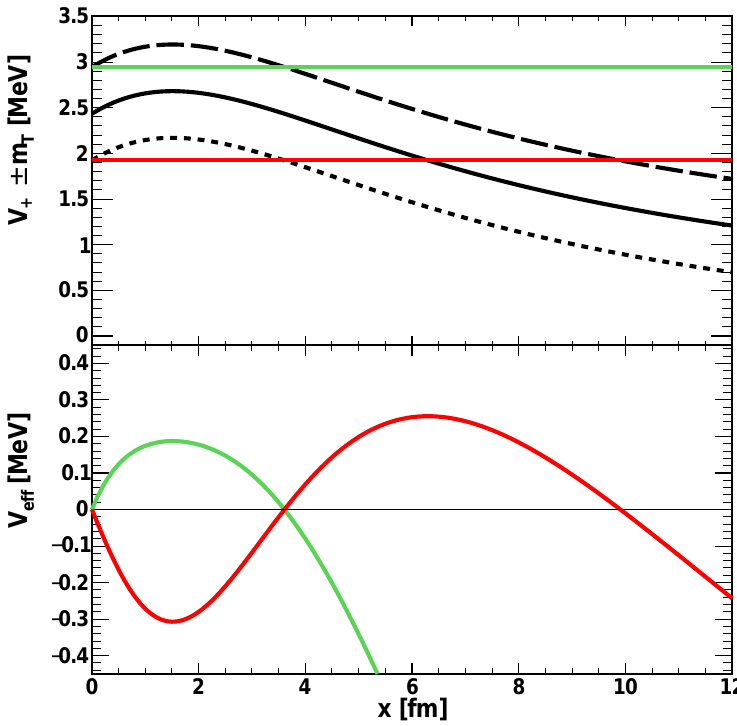
Figure 2. (Color online) An illustrative example when V ef f ( R ,0 ) = 0. In the bottom panel we plot V ef f vs. x and the corresponding potential with full line ( ± m T = m e —top panel, dashed and dotted lines) seen by the positron. The calculations are performed for 12 C+ 12 C